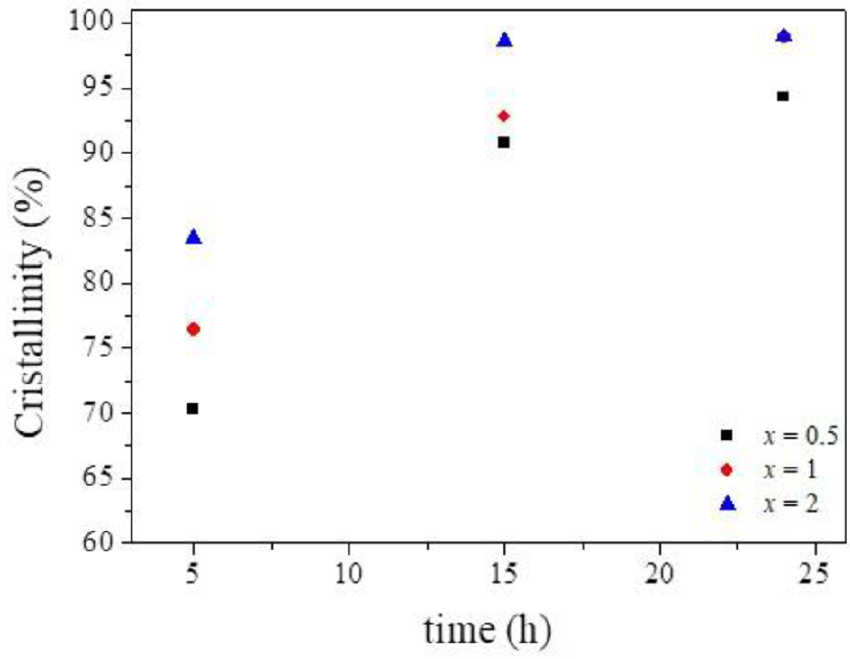
Figure 5. Crystallinity curve.